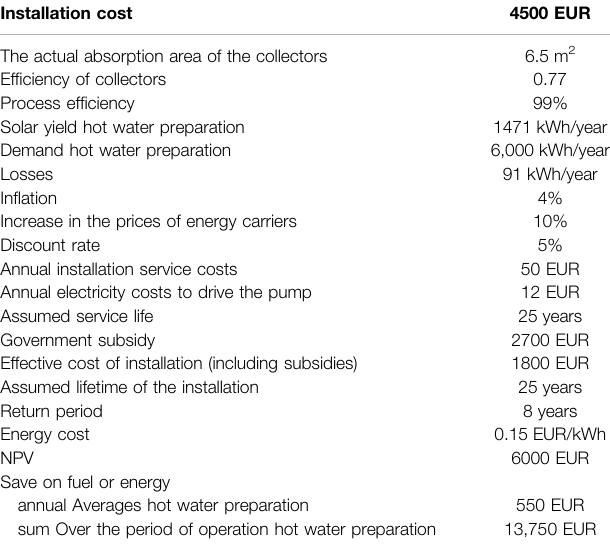
TABLE 2 | Data used to calculate the payback time of the investment.